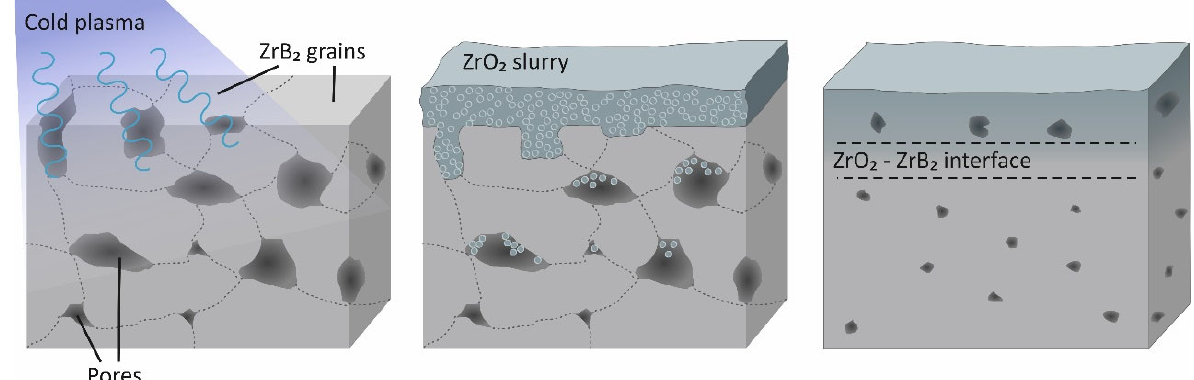
Figure 2. Schematic of the immersion ZrO 2 coating formation on pre ‐ sintered ZrB 2 –SiC.